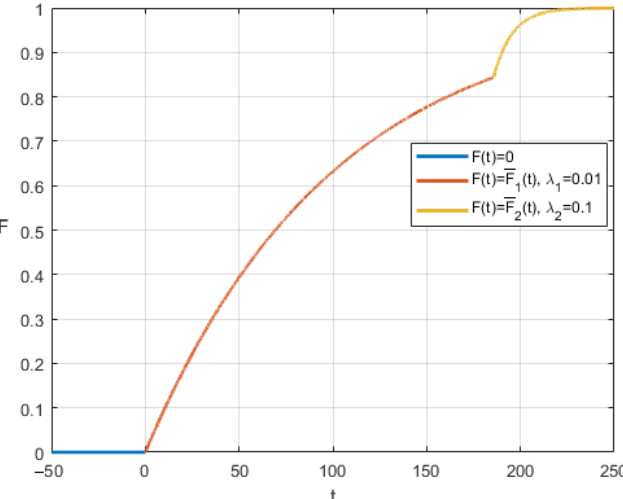
Figure 4. Cumulative distribution function ( λ 1 = 0.01, λ 2 = 0.1, τ 1 = τ ∗